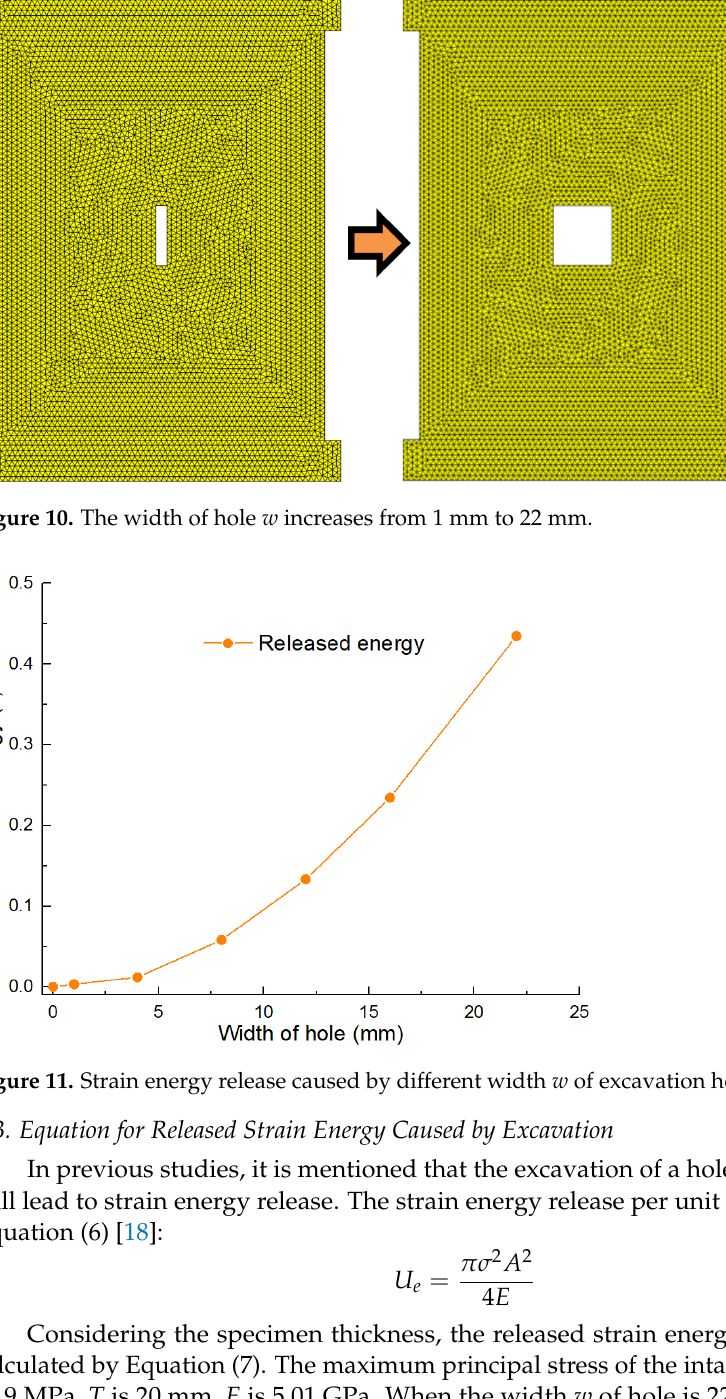
0.435 Figure 9. Strain energy release caused by different heights h of excavation holes.